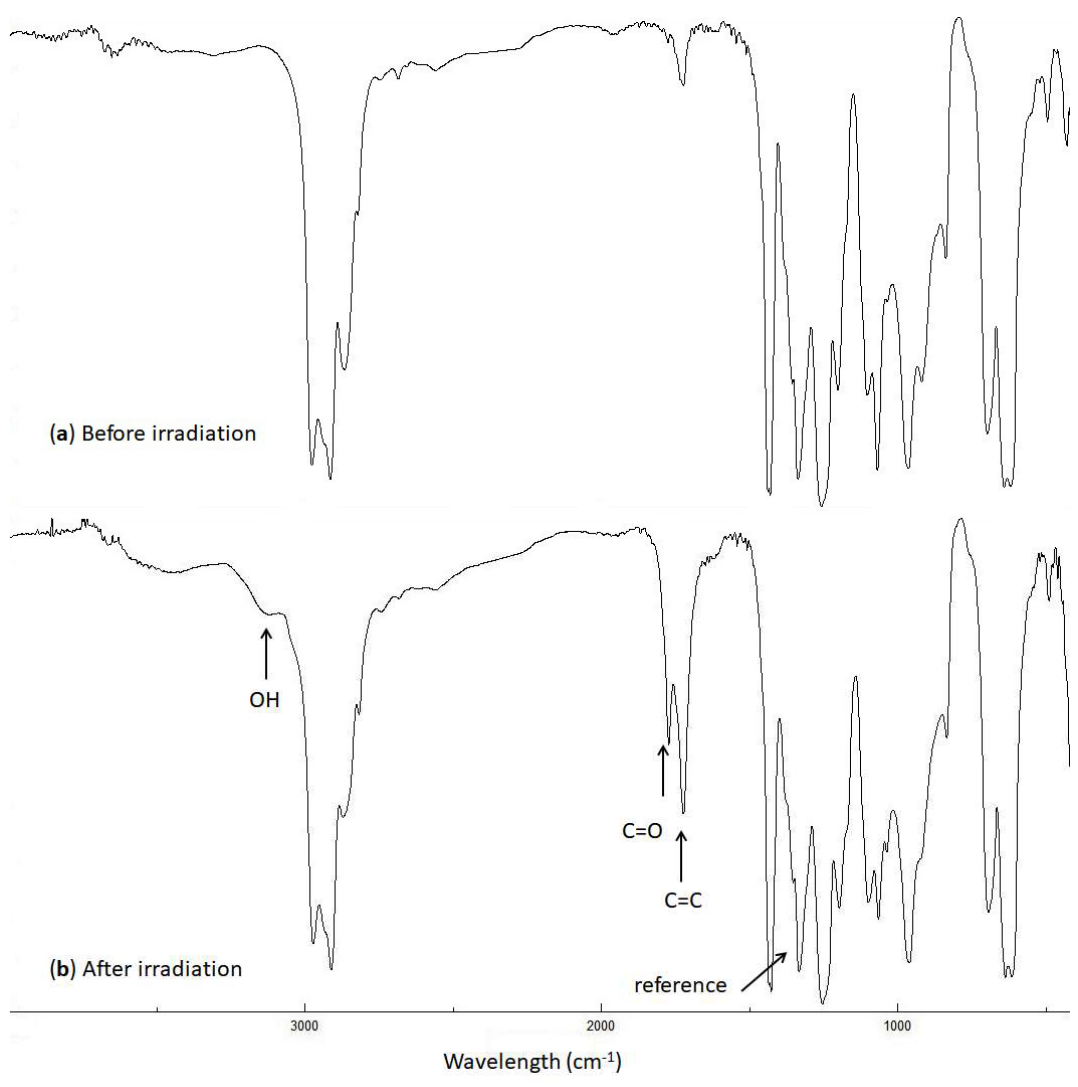
Figure 3. FTIR spectra of the blank PVC film ( a ) before and ( b ) after irradiation (300 h).